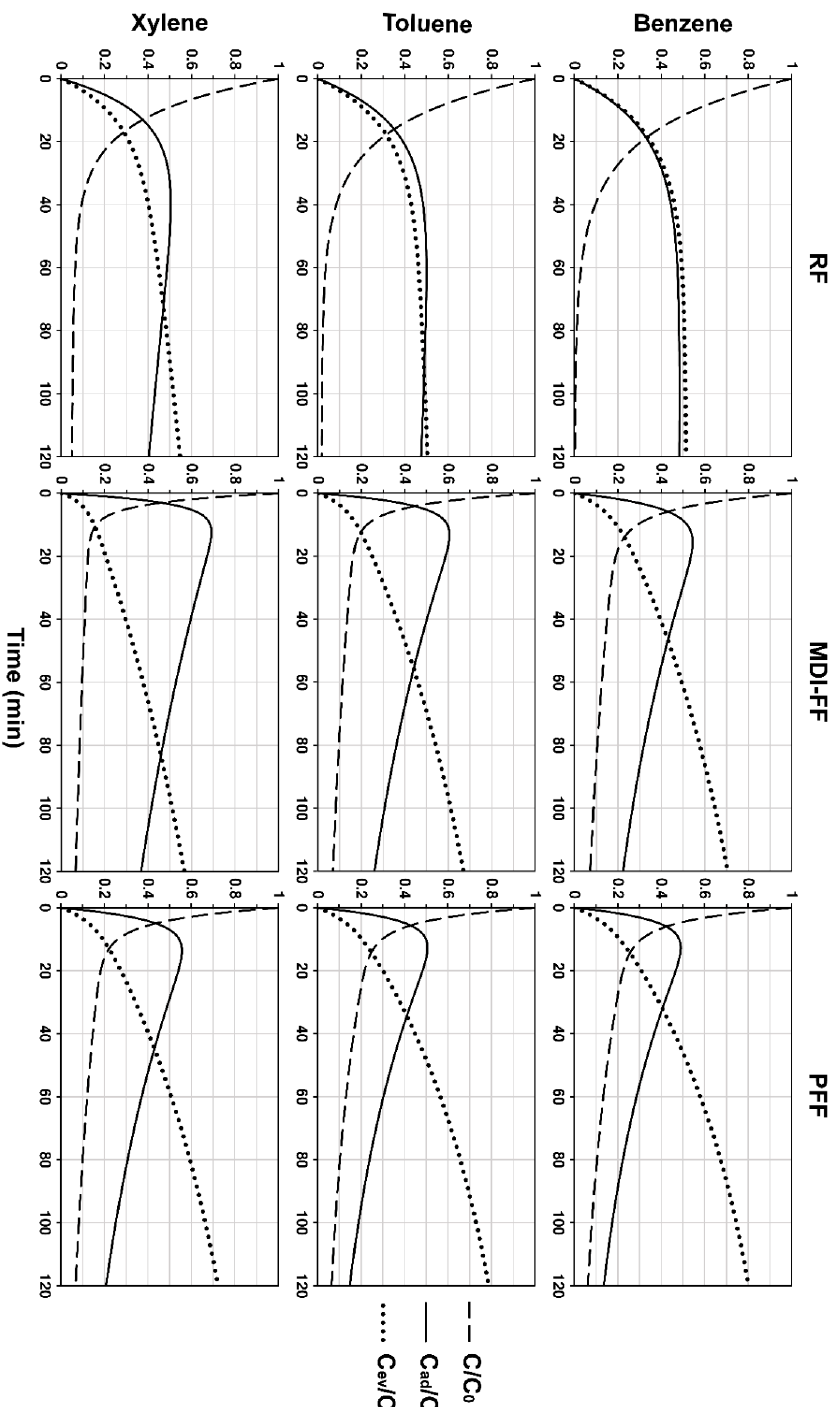
Figure 6. Trend of the dissolved ( C ), adsorbed ( C ad ) and evaporated ( C ev ) BTX concentration with time, calculated by the model using Table 3 results.